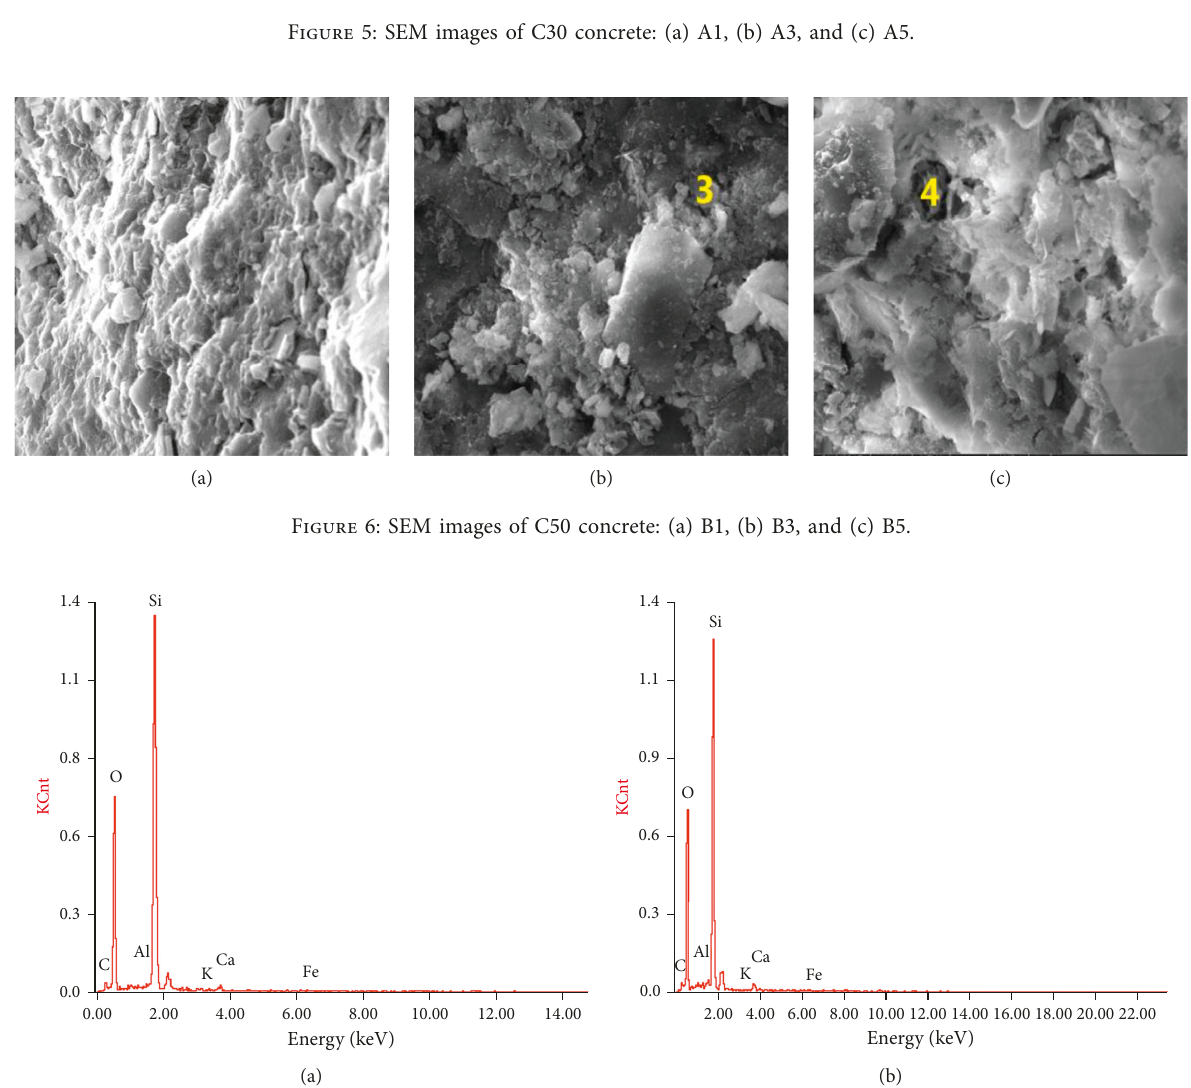
Figure 7: Energy spectrums of paste from Figures 5(b) “1” and 5(c) “2”: (a) EDS from Figure 5(b) and (b) EDS from Figure